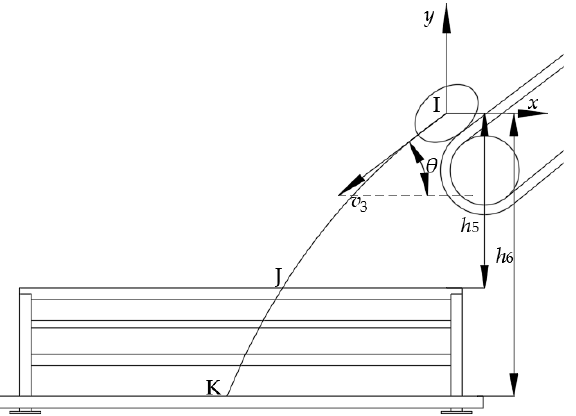
Figure 12. Force analysis diagram of a potato in the receiving section of the circulating and lifting device.